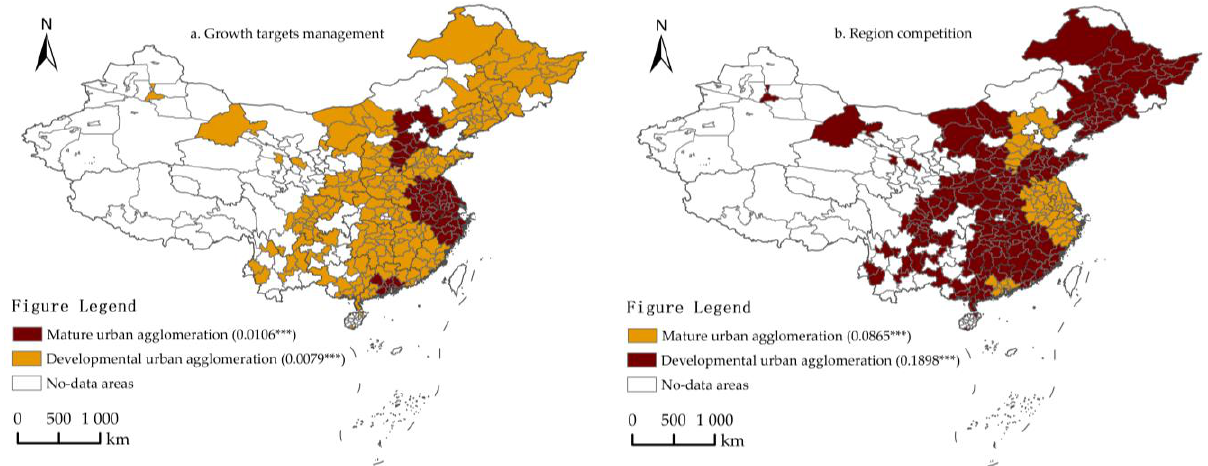
Figure 6. Heterogeneity analysis results (Urban agglomerations). ( a ) The impact of growth targets management (gt) on the ULUGE; ( b ) the impact of regional competition (w·gt) on the ULUGE. *** denotes significance at the 0.01 level. As above, the shade of the color represents the relative strength of the effect. Table 12. Heterogeneity analysis results (Urban agglomerations).